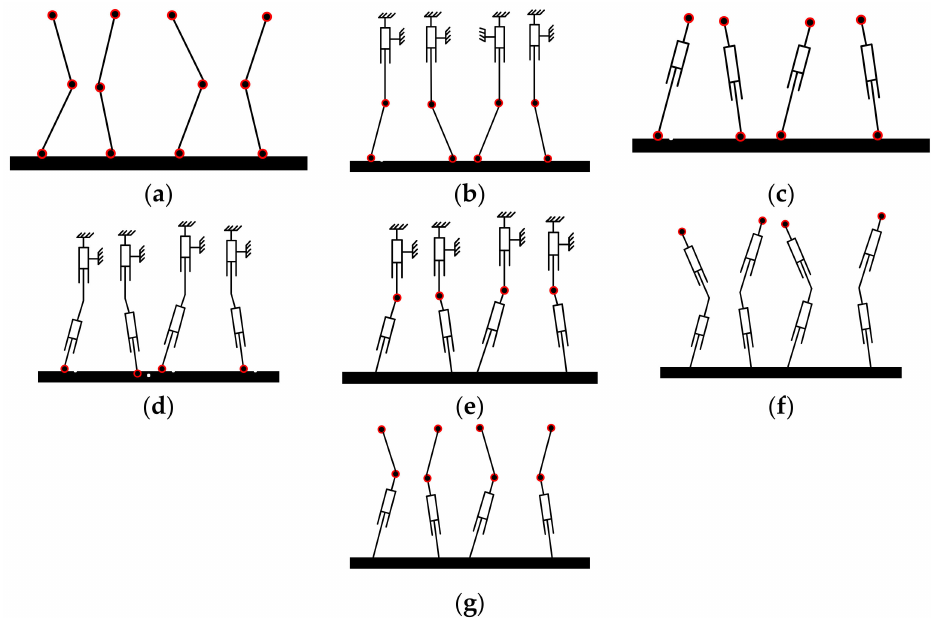
Figure 2. Types of 3-DoF planar parallel part. ( a ) 4-RRR planar parallel part; ( b ) 4-PRR planar parallel part; ( c ) 4-RPR planar parallel part; ( d ) 4-PPR planar parallel part; ( e ) 4-PRP planar parallel